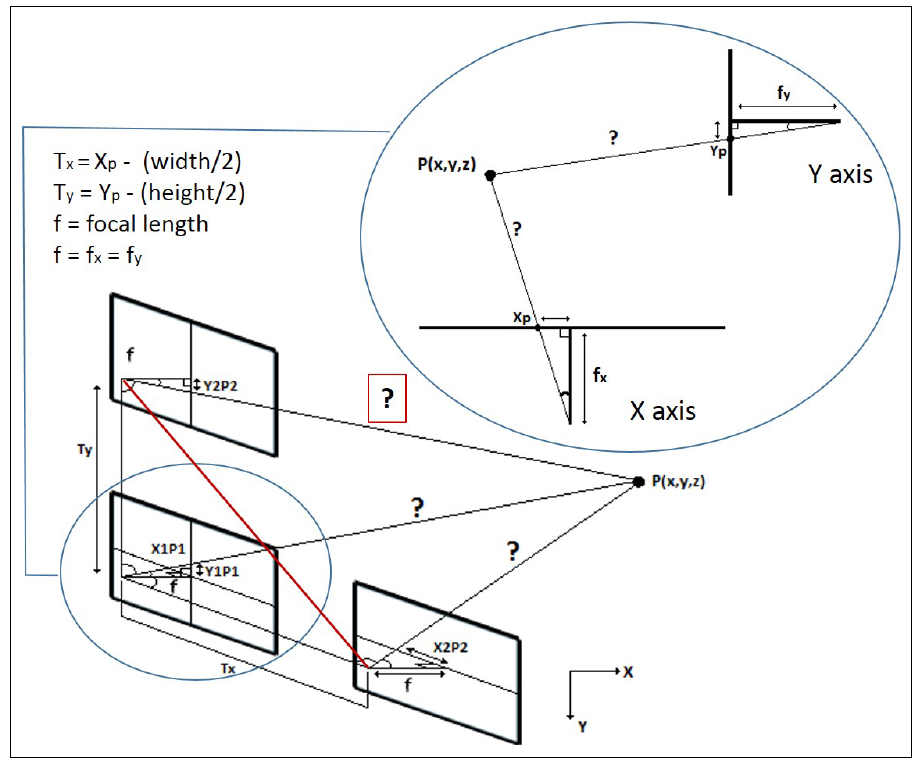
Figure 5. Triangulation proposal in X and Y axis. X1P1 and Y1P1 are the projection of the point (P)